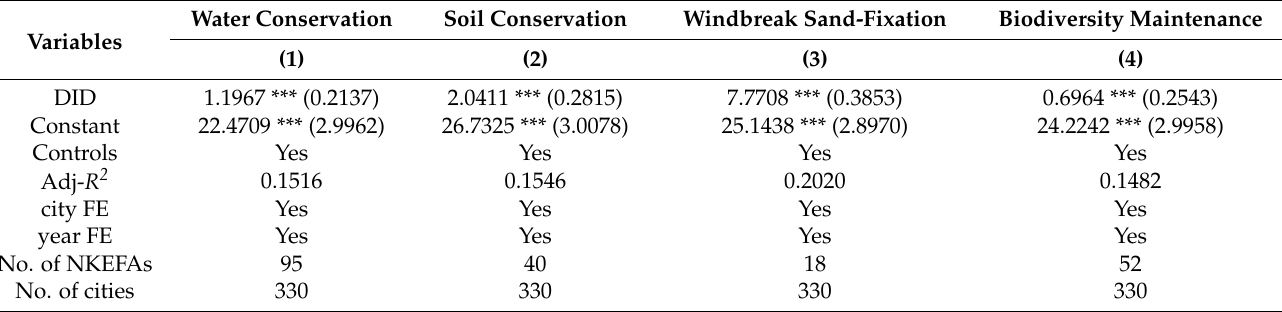
Table 5. Heterogeneity analysis: differences based on function